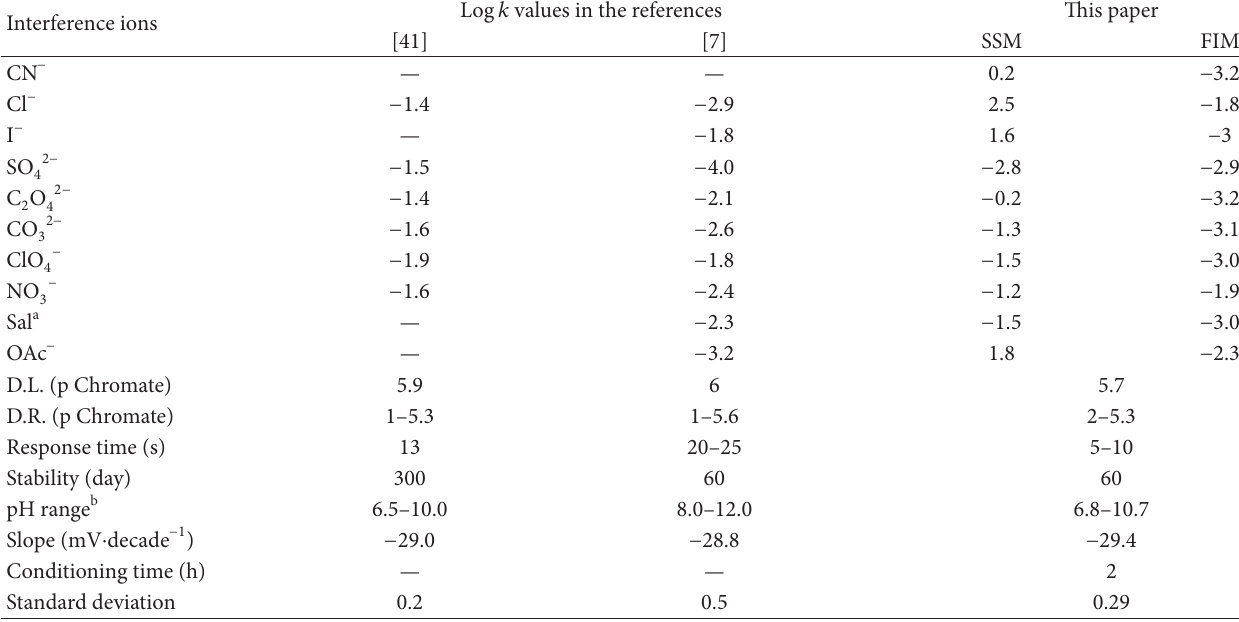
T 7: Comparison of some potentiometric characteristics of the chromate ISE described in this paper with previously published reports. Interference ions